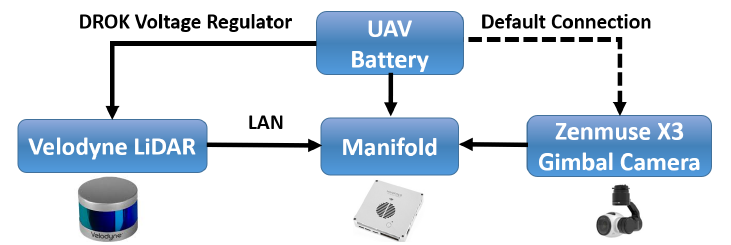
Figure 4. Velodyne sensor, Manifold onboard computer, and Zenmuse X3 hardware integration with UAV.